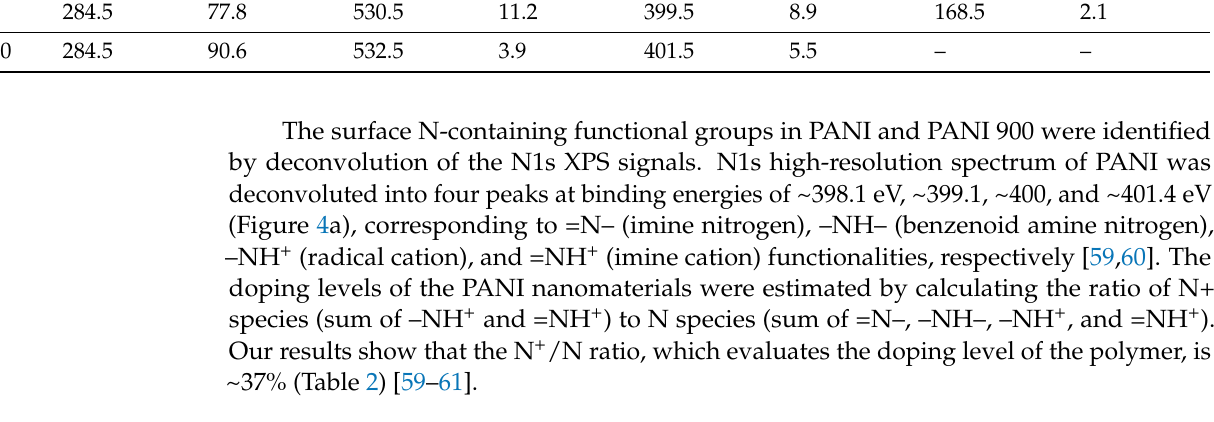
Table 2. Relative quantities of surface-nitrogen-containing groups of PANI and PANI 900 obtained from N(1s)